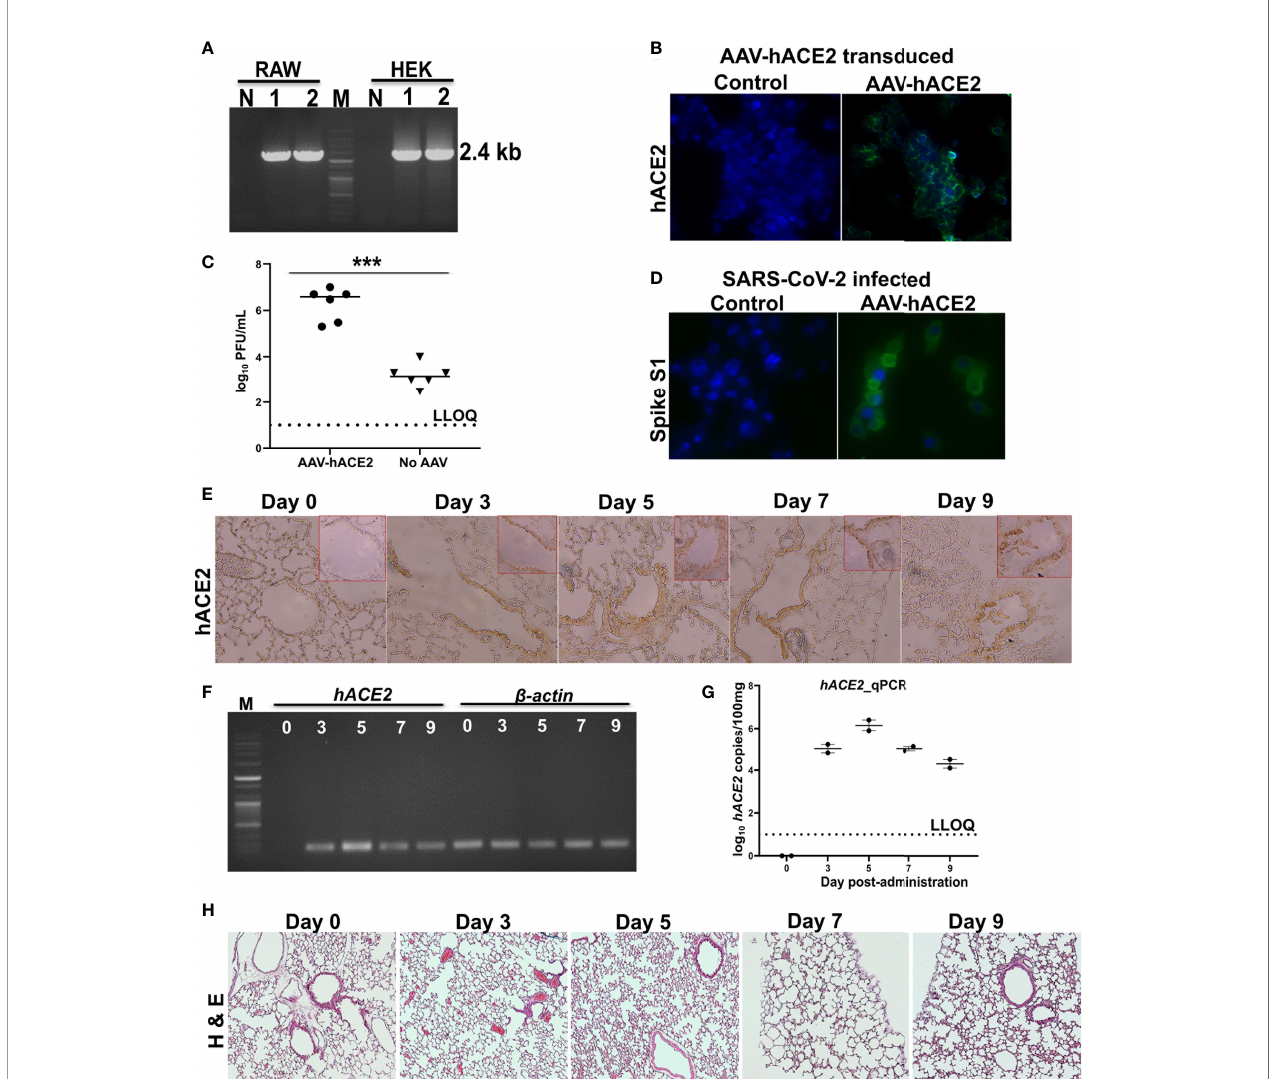
FIGURE 1 | Expression kinetics of hACE2. (A) hACE2 mRNA expression in AAV-hACE2 transduced HEK and RAW cells by RT-PCR. Lane M- DNA molecular weight marker; Lane 1, 2- replicates showing the ampli fi cation; Lane N- absence of ampli fi cation in non-transduced cells. (B) Expression of hACE2 in AAV-hACE2 transduced RAW cells by IFA using ACE2 antibody. Bright green fl uorescence indicating the expression of hACE2 on cell surface. AAV-hACE2 transduced RAW cells were infected with SARS-CoV-2 at 0.1 moi and viral replication was determined by (C) plaque assay and (D) IFA using spike S1 antibody. Mice were intranasally transduced with AAV-hACE2 and expression of hACE2 in the lungs was evaluated by (E) IHC using ACE2 antibody, (F) RT-PCR to amplify a fragment of ACE2 and (G) qRT-PCR. Lane M- DNA molecular weight marker; Lane 0, 3, 5, 7 and 9 indicate the lung sampling day after transduction. Ampli fi cation of internal control b -actin has been shown. (H) H & E stained lung tissues after adenoviral transduction. Dashed line in (C) and (G) represents lower limit of quanti fi cation (LLOQ). Data information: Data in (C) was analysed by Mann Whitney test. Data in (E – H) are representative of two mice at each time point from a total of 10. Data presented as mean ± SEM at 95% CI. ***p <